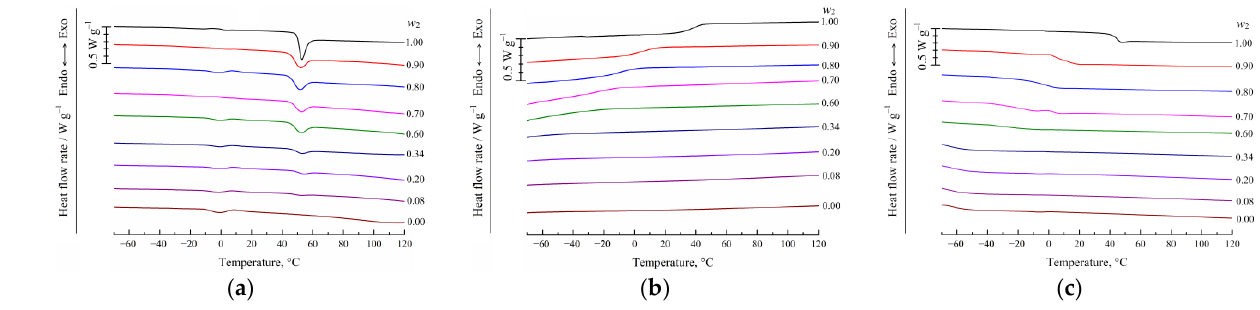
Figure 2. Thermograms of PLGA, TG, and their mixtures (PLGA mass fraction indicated on the